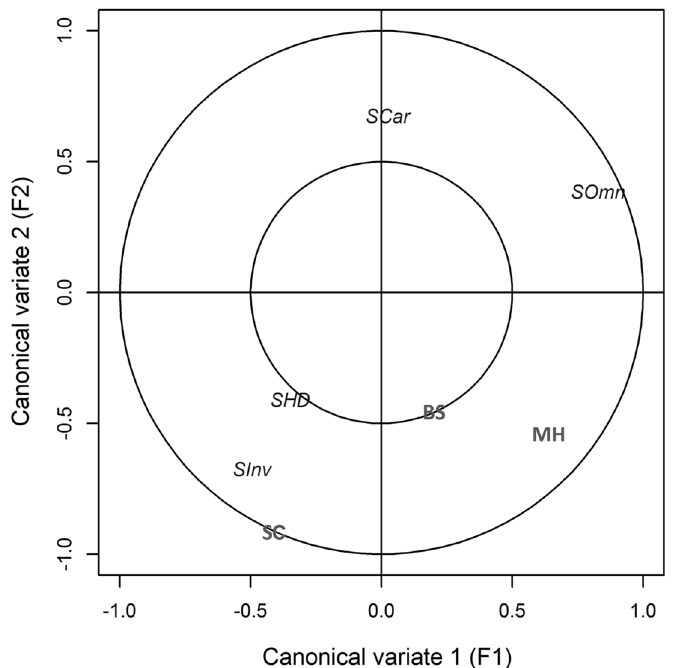
FIGURE 3 | Biplot of the first two canonical functions showing how substrate composition (SC), meso-habitat variability (MH), and bank stability (BS) correlate with richness of carnivores (SCar), invertivores (SInv), omnivores (SOmn), and herbivorous-detritivores